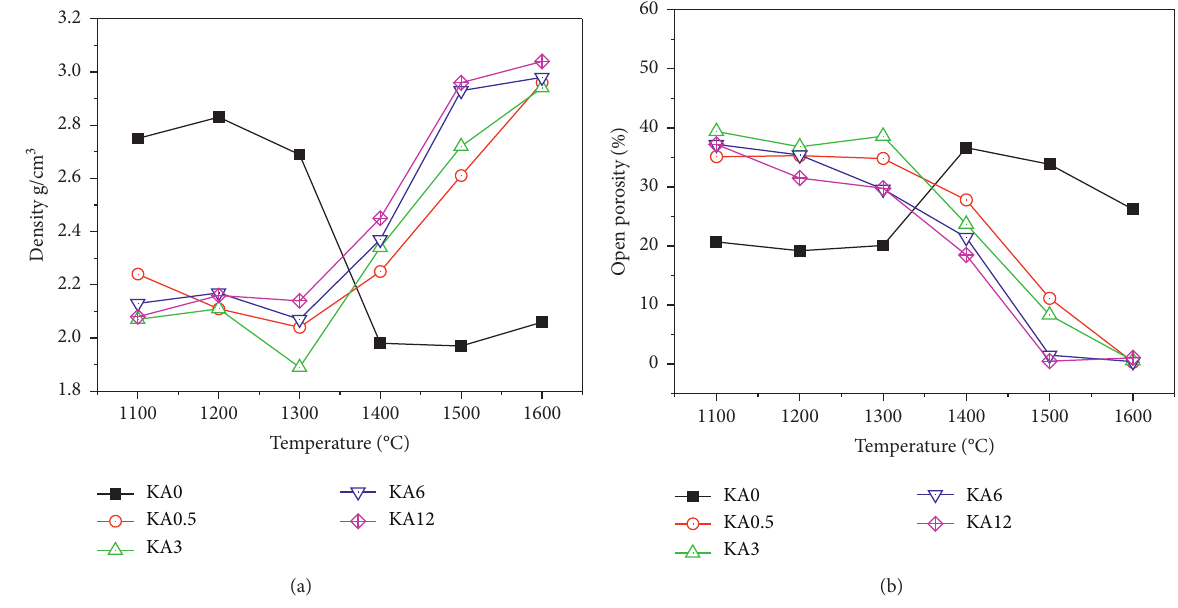
Figure 10: Density (a) and open porosity (b) of samples as function of sintering temperature and ball milling